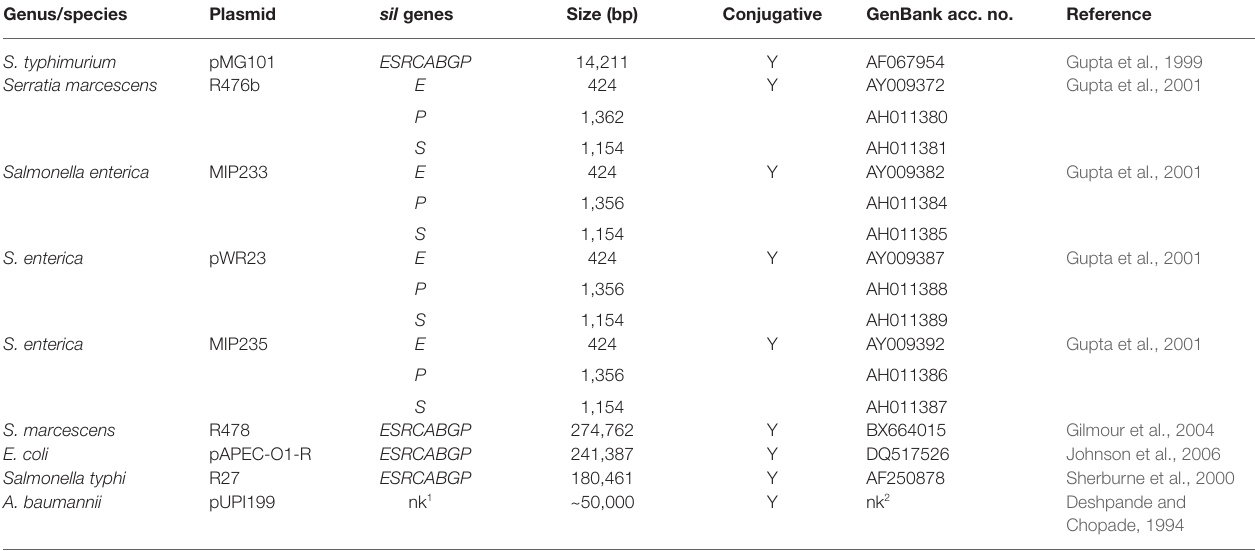
TABLE 2 | Properties of known HI incompatibility group (IncHI) plasmids containing genes coding for silver resistance, including either the complete sil operon or some sil genes.